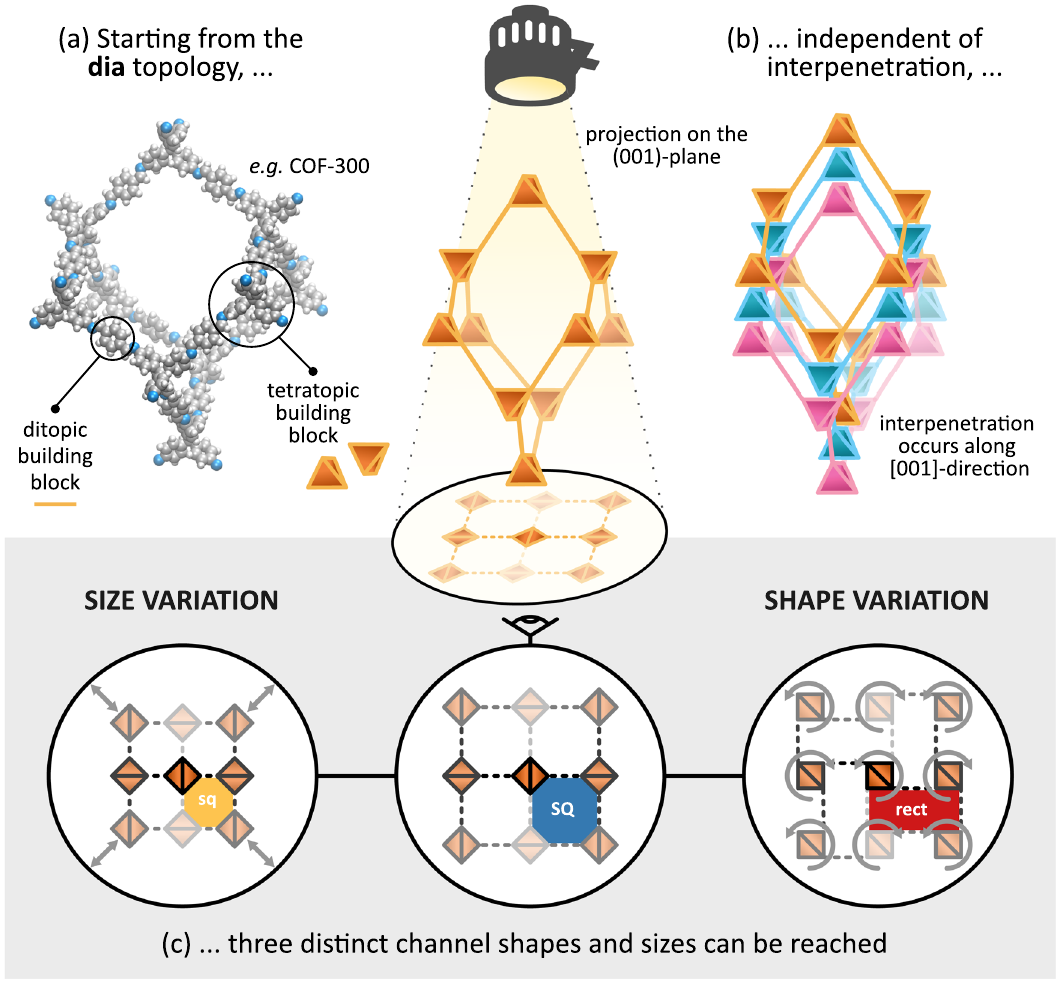
Fig. 2 Illustration of the dia topology and its experimental channel behaviour. The dia topology is elaborated by depicting the a non-interpenetrated atomic representation of COF-300 and b a threefold interpenetrated diamondoid framework. c When viewed along the ideal twofold rotation axis ([001]- direction), three distinct channel shapes and sizes emerge, namely, sq, SQ and rect, independent of the degree of interpenetration. These channel shapes and sizes are de fi ned by the relative orientation and distance between adjacent tetratopic building